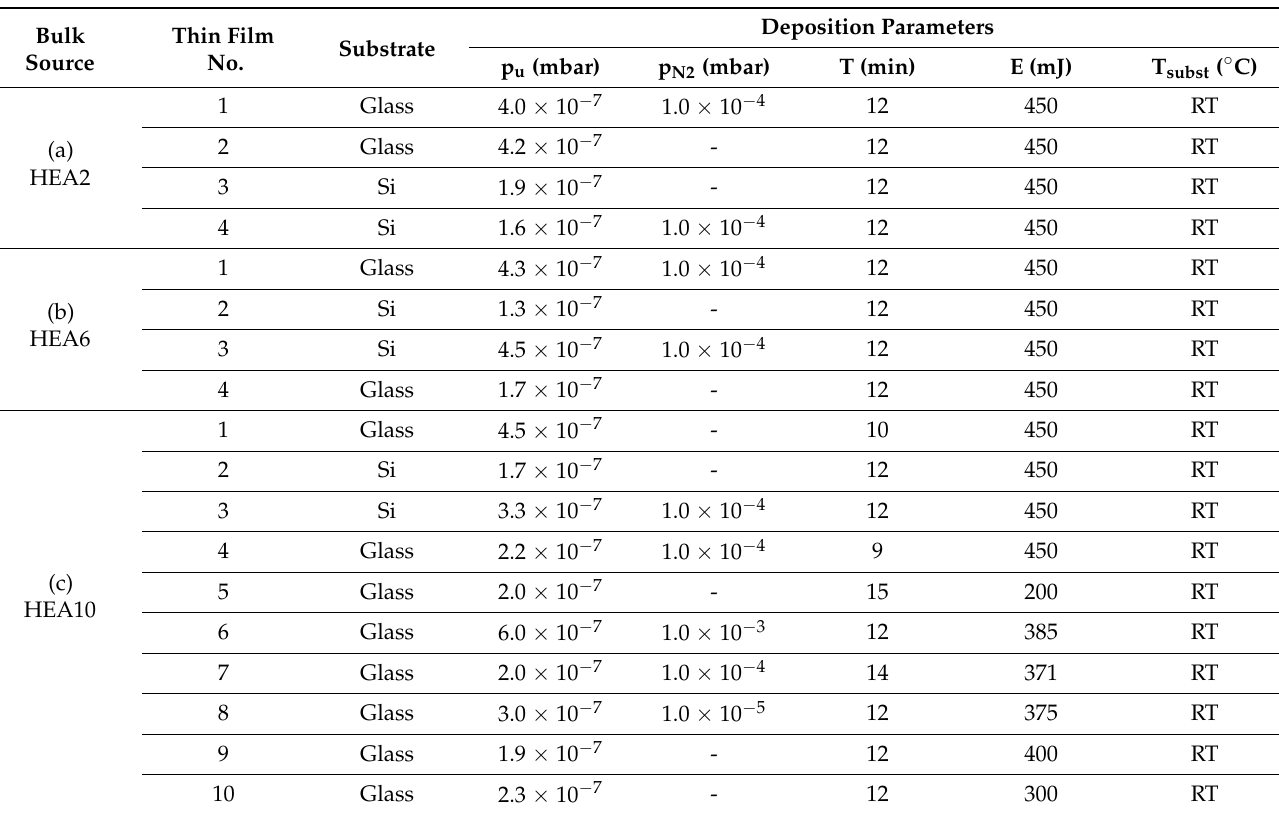
Table 1. Summaries of thin HEA and HEN films grown from (a) HEA2, (b) HEA6, and (c) HEA10 SS targets of crystalline structures from BCC (top) to FCC (bottom) lattice